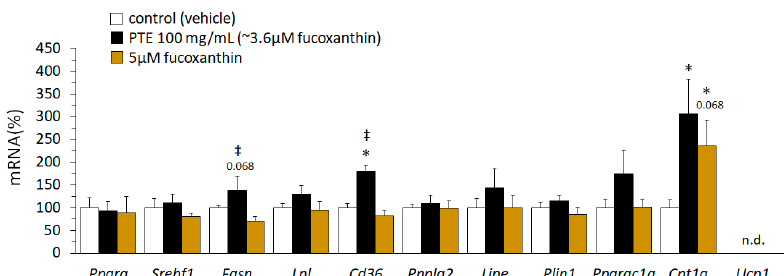
Figure 5. Phaeodactylum tricornutum ethanolic extract (PTE) and fucoxanthin e ff ects on gene expression in mature 3T3-L1 adipocytes are not equivalent. mRNA levels of selected genes in mature 3T3-L1 adipocytes are shown. 3T3-L1 preadipocytes were grown and di ff erentiated following a standard protocol. On day 7, cultures were treated with PTE (100 mg / L), fucoxanthin (5 µ M; Sigma-Aldrich), or vehicle (ethanol 0.5%) for 24 h. Data are the mean ± SEM of two independent experiments made in triplicate and are expressed relative to the mean value of the vehicle group, which was set to 100. To compare between two groups the non-parametric Mann–Whitney test was used: *, di ff erent from vehicle; and ‡ , di ff erent from fucoxanthin. Threshold of statistical significance was set at p < 0.05, p values < 0.1 are also indicated.